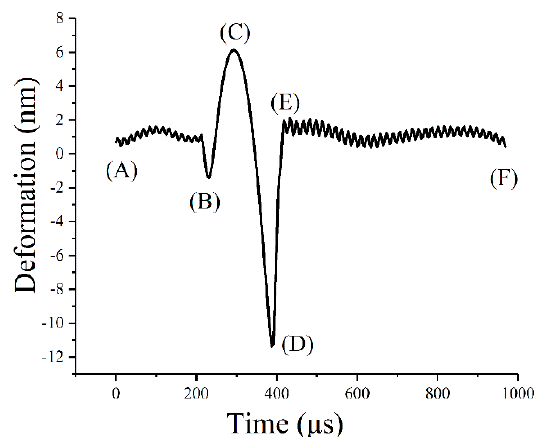
Polymers 2018 , 10 , x FOR PEER REVIEW Figure 8. Force curve of bitumen in the Atomic Force Microscope (AFM) test. Figure 8. Force curve of bitumen in the Atomic Force Microscope (AFM) test.